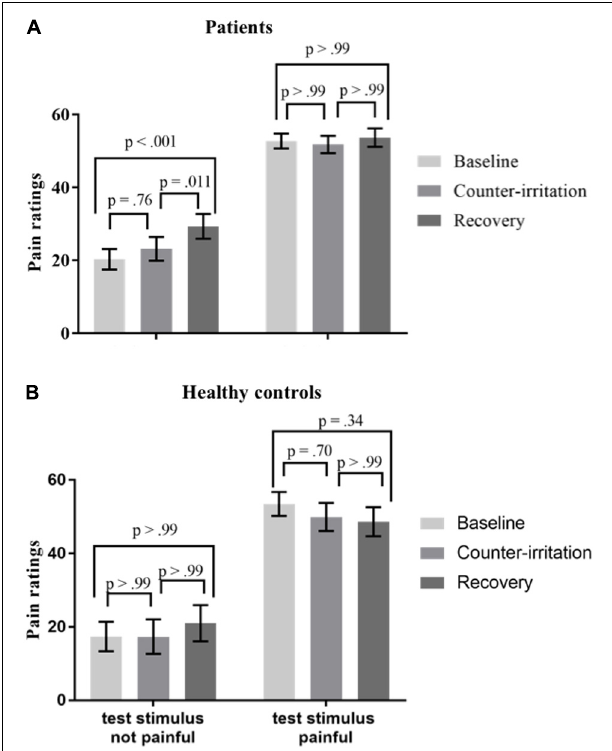
FIGURE 4 | Least square mean pain ratings for electrocutaneous stimuli for (A) patients and (B) HC who did and did not experience the test stimulus as painful (average electrocutaneous pain rating in baseline ≥ 40) in the baseline, counter-irritation, and recovery phase. 27 patients and 13 HC found the test stimulus not painful, 51 patients and 20 HC found the test stimulus painful. p -values are corrected for multiple testing with the stepdown Bonferroni method. Vertical bars denote standard